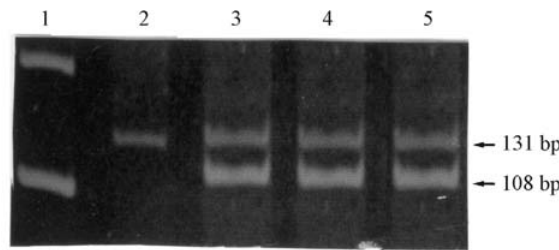
Figure 1 - Polymerase chain reaction and restriction site assays for detec- tion of IVS4+4A → T mutation of the FANCC gene in Fanconi anaemia. Ethidium-bromide stained 7% polyacrylamide gel showing fragments of 131bpand108bpcorrespondingtothemutantandnormalalleles,respec- tively. Lane 1 shows the DNA size marker leader 100 bp. Lane 2 shows the result from an individual with homozygous IVS4+4A → T mutation used as control, and lanes 3 to 5 show the results from heterozygous indi-